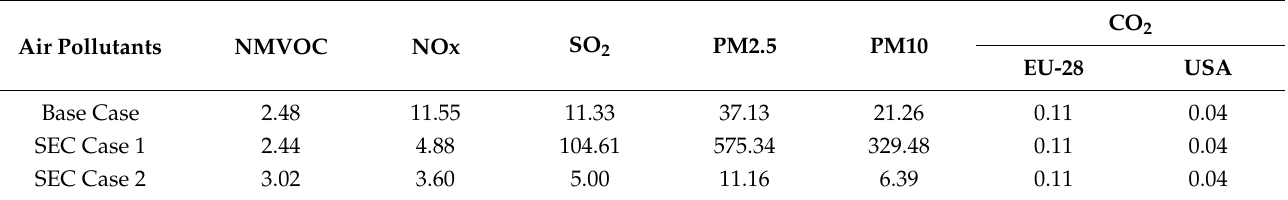
Table 12. Estimated marginal social environmental cost of air pollution from ships using the inter- national BTM [USD 2019 1000/ton].